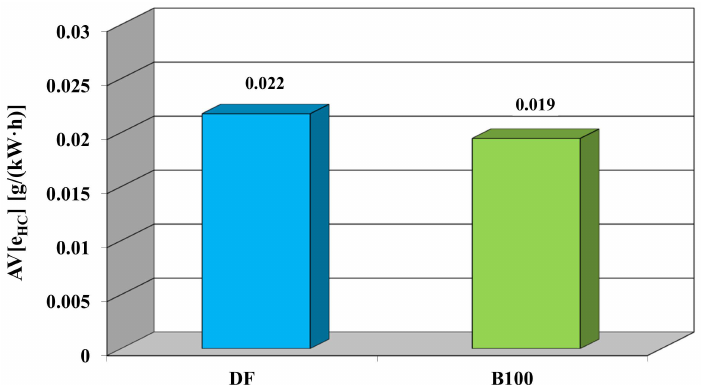
Figure 10. Average value—AV in the speed domain of the specific brake emissions of hydrocarbons e HC for the engine powered with fuels DF diesel or